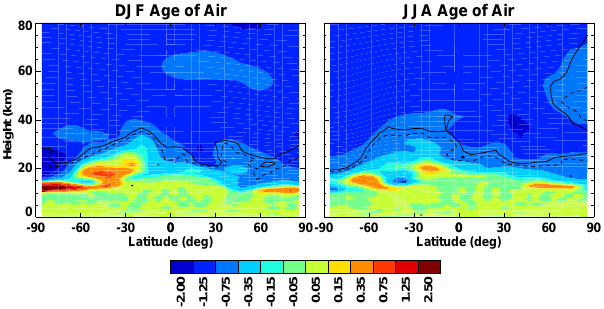
Fig. 15. Run mean, ensemble mean difference (%) between the two ensembles shown in Fig. 14 for age of air.